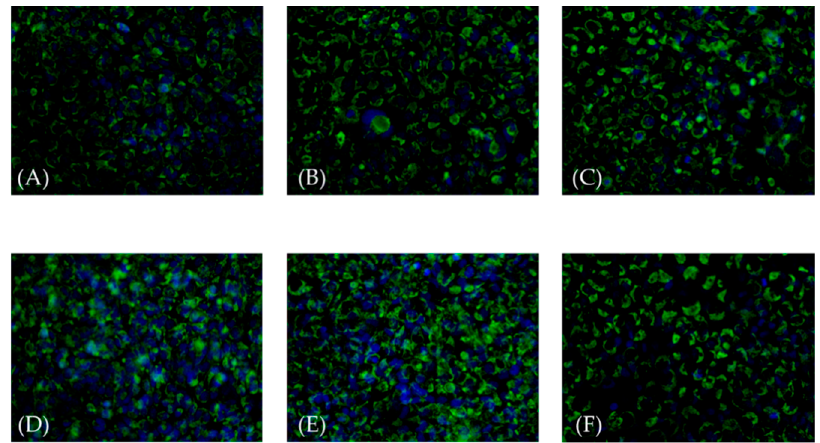
Figure 13. Merged microscopic images of TSPO expression and apoptosis in H1299 lung cancer cells. The microscopic images representing the fluorescence intensity of both Hoechst staining (blue) and of TSPO expression (green) were merged, demonstrating the association between TSPO and apoptotic cell death: ( A ) the control group; ( B ) group of cells pretreated with MGV-1 and exposed to fresh air; ( C ) group of cells pretreated with 2-Cl-MGV-1 and exposed to fresh air; ( D ) group of cells exposed to CS without pretreatment; ( E ) group of cells pretreated with MGV-1 and exposed to CS; ( F ) group of cells pretreated with 2-Cl-MGV-1 and exposed to CS. CS = cigarette smoke.